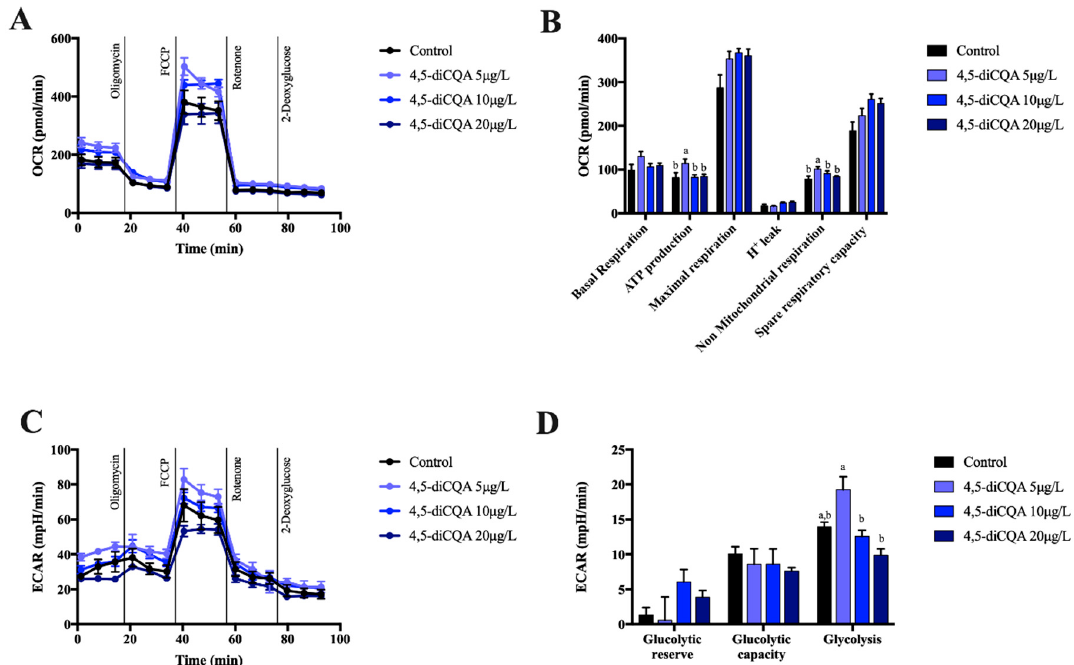
Figure 5. Oxygen consumption rate (OCR) ( A ), mitochondrial function parameters ( B ), extracellular acidification rate (ECAR) ( C ), and glycolytic parameters ( D ) in mouse primary hepatocytes incubated for 18 h with different concentrations of 4,5-diCQA. Each bar is the mean ± SEM of three independent experiments and analyzed by one-way ANOVA followed by Tukey multiple comparison post hoc test. The differences were considered statistically significant at p < 0.05. Mean values with different lowercase letters show statistical differences between each other.